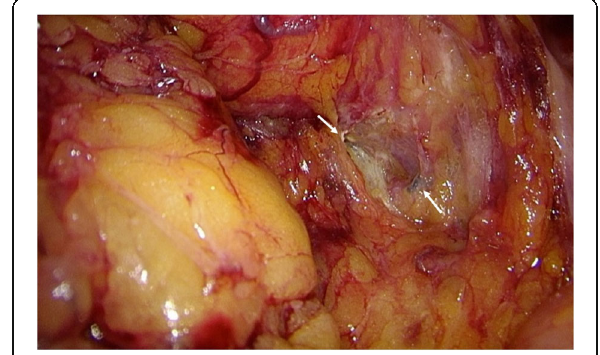
Fig. 7 Laparoscopic low anterior resection was performed on the day following IVR. Coils in inflow vessels were revealed on the exfoliated surface in the